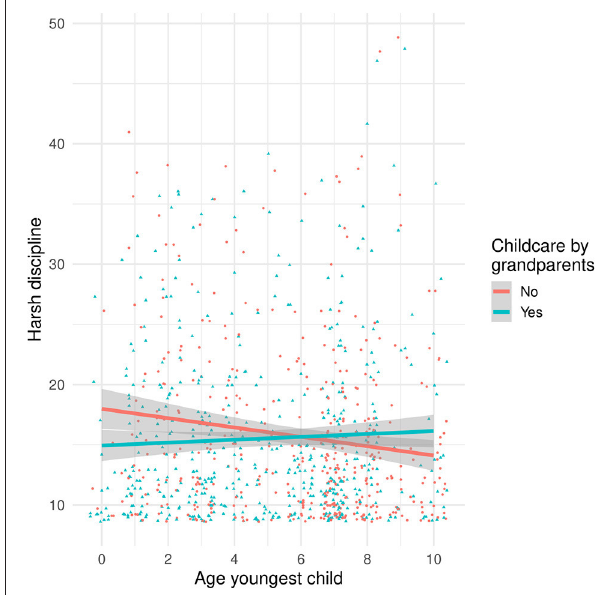
FIGURE 3 | Scatterplot showing the Interaction between age of the youngest child and Chinese grandparental childcare (separate lines) on harsh discipline